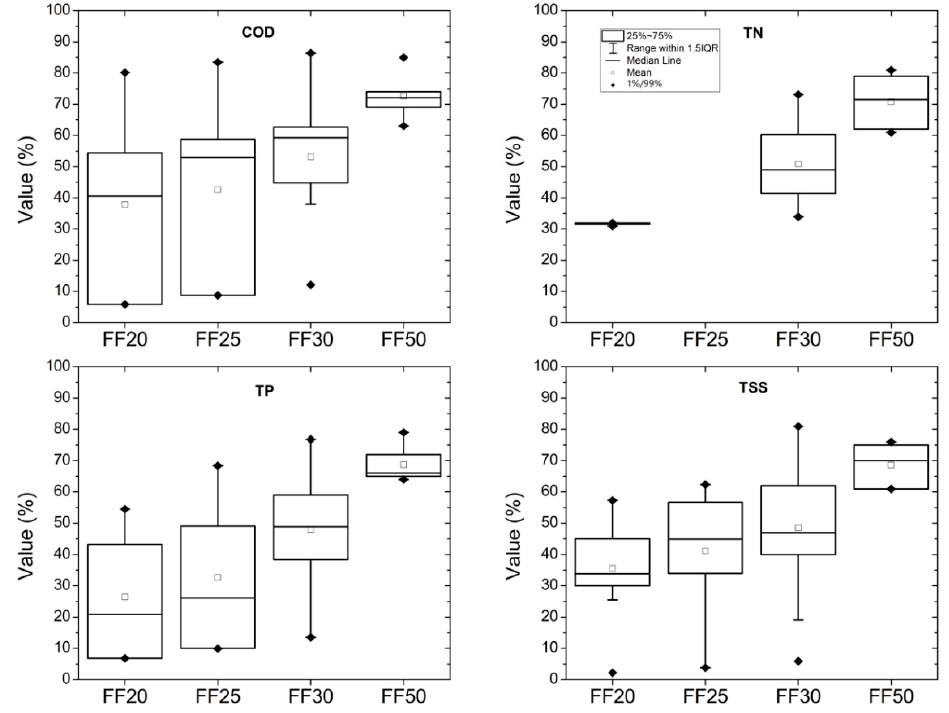
Figure 8. Box plots of FF values gathered from the reviewed research articles on first flush.